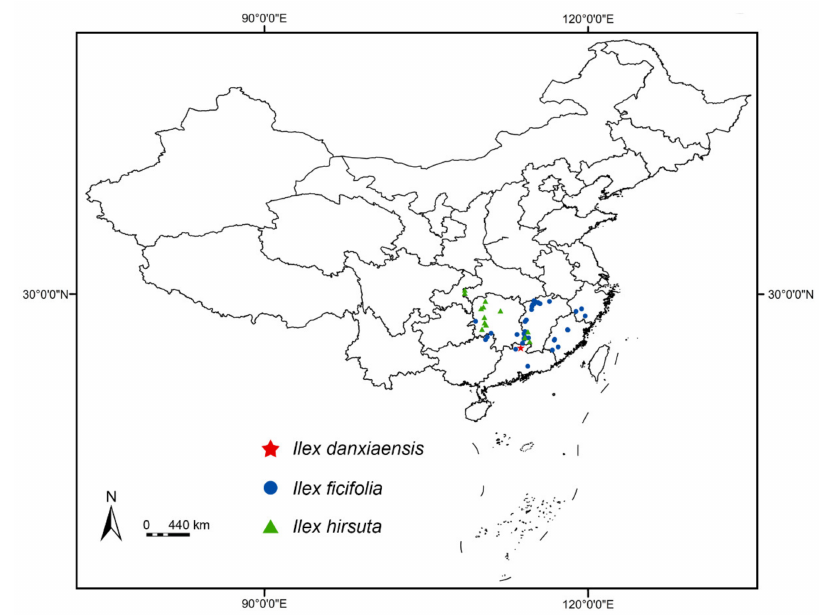
Figure 1. Distribution map of the three morphological similar species Ilex danxiaensis , I. ficifolia , and I. hirsuta in China, on the basis of the specimens examined in this study and flora of